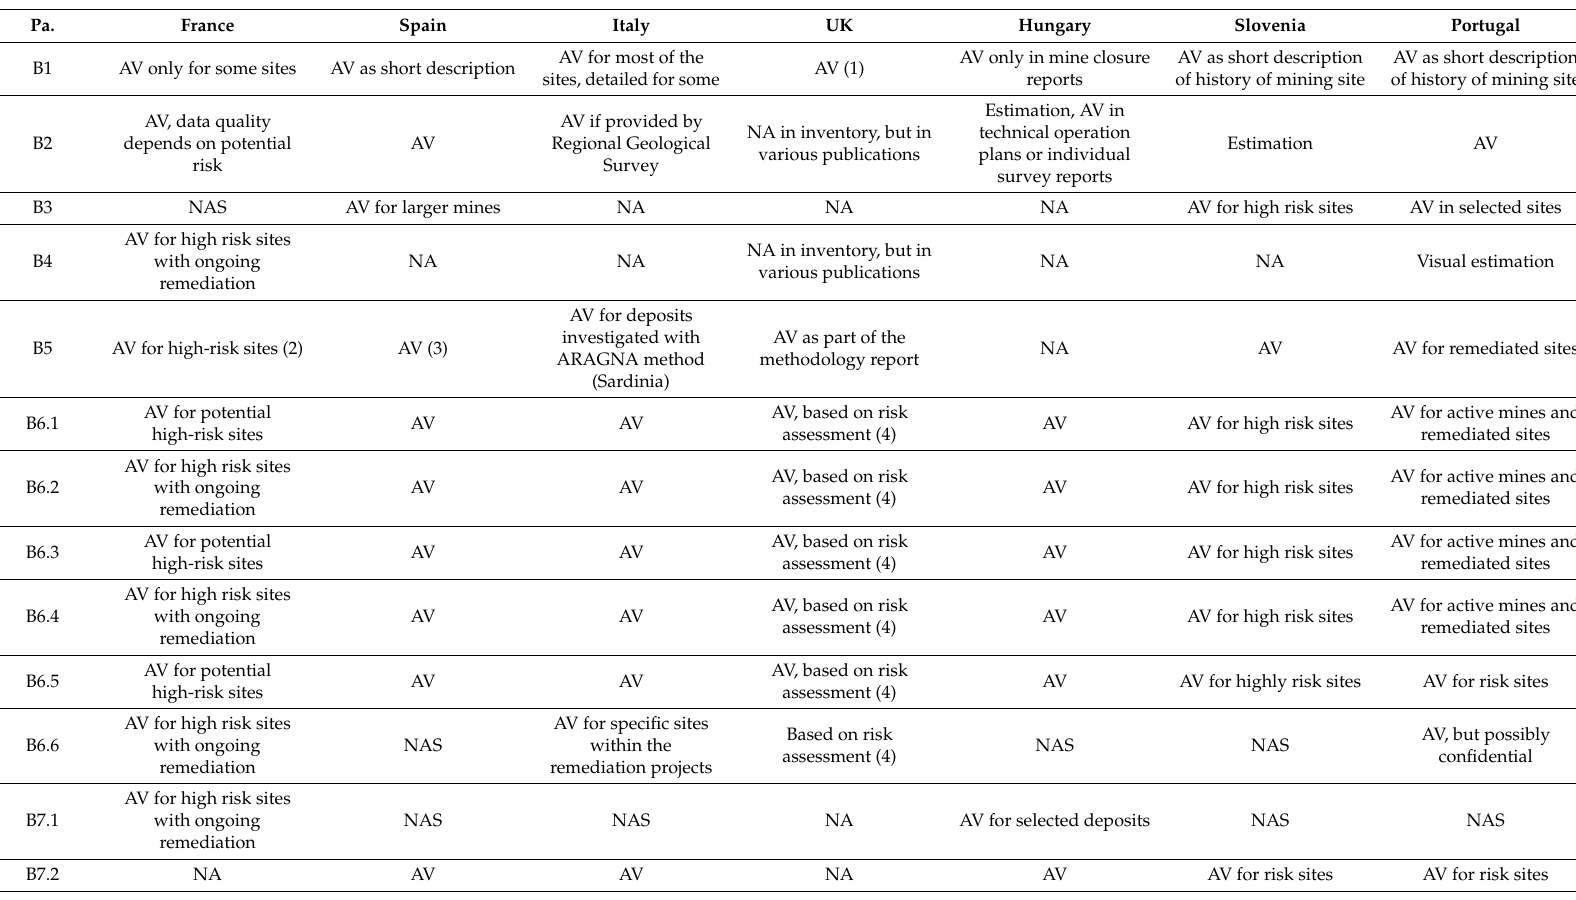
Table 3. Key “basic” valorisation parameters (Pa.)—data availability in di ff erent EU countries (AV—Available, NA—Not Available, NAS—Not Assessed).